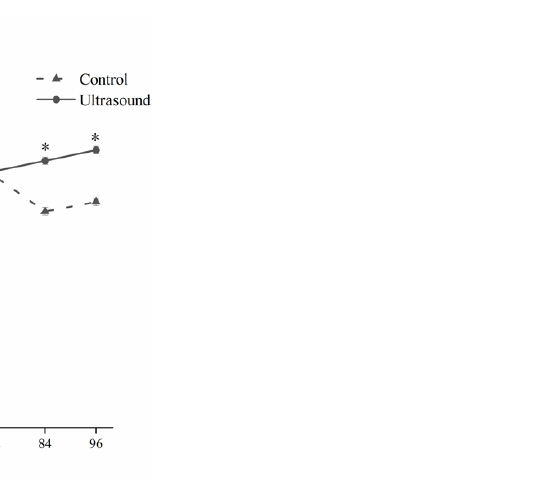
Figure 3. The effect of ultrasound induction treatment on dry matter ( A ), starch content ( B ), and reducing sugar content ( C ) during maize germination. * Indicates a significant difference ( p < 0.05) between the ultrasound and control